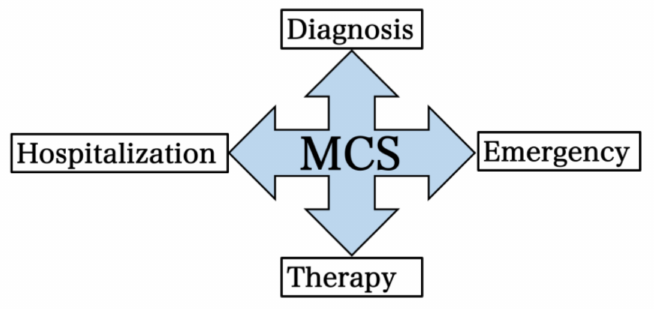
Figure 1. Research domains identified during the pre-Delphi. MCS: multiple chemical sensitivity.